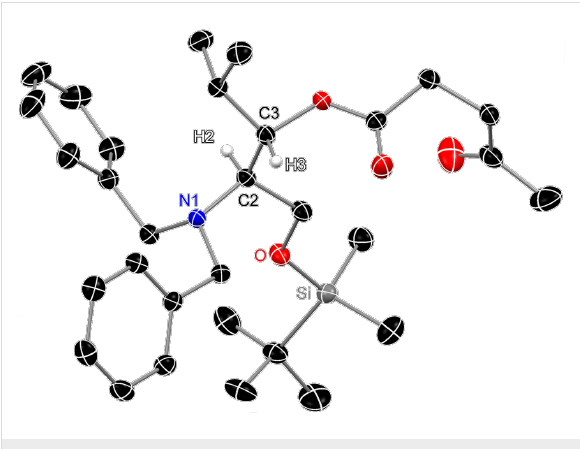
Figure 2: Molecular structure of levulinyl ester 6 . Anisotropic displace- ment parameters are depicted at the 50% probability level. Atom color code: carbon = black, oxygen = red, nitrogen = blue, silicon = grey, and hydrogen = white. The other hydrogen atoms are omitted for